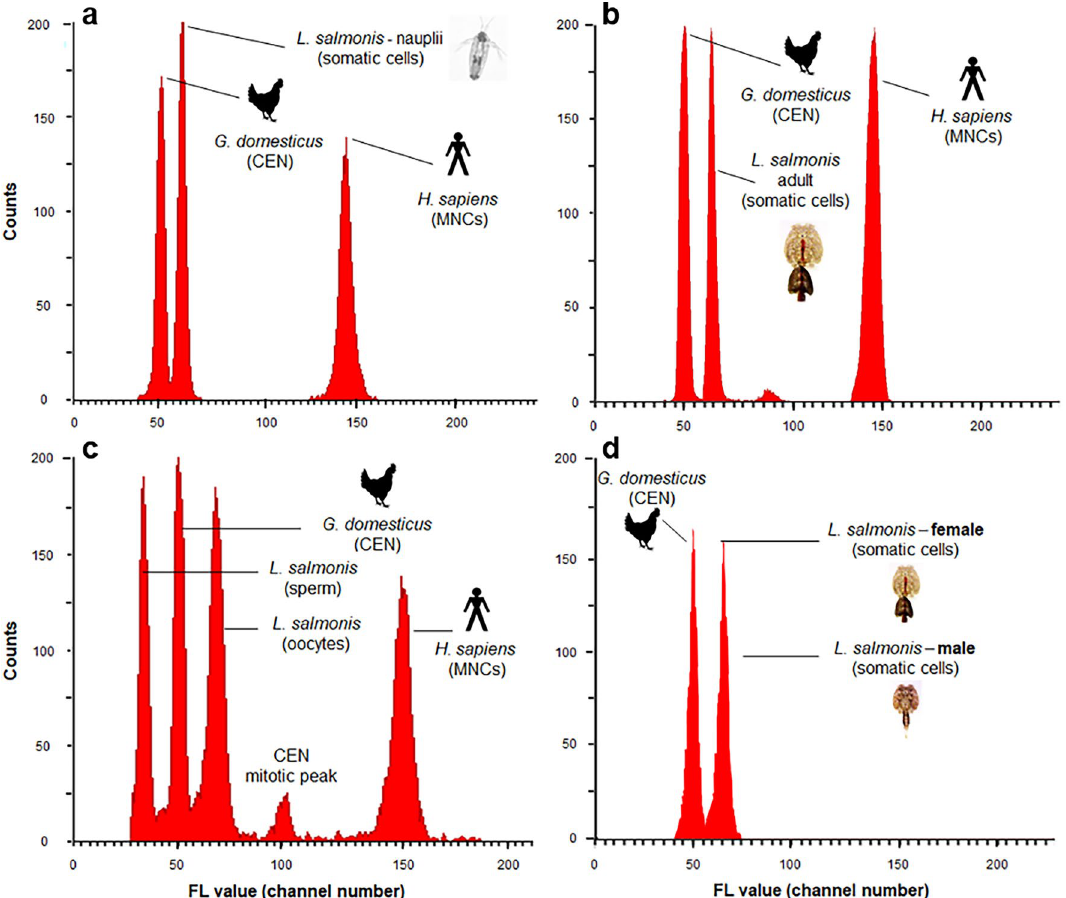
Figure 1. Representative fluorescence histograms of PI-stained somatic and gametic cells of L. salmonis salmonis . ( a ) Run 1, somatic cells obtained from whole body squash of nauplii; ( b ) run 3, somatic cells obtained from cephalic regions of adult females; ( c ) run 4; oocyte and sperm samples; ( d ) run 5, somatic cells obtained from cephalic regions of adult males and females. Samples analyzed using chicken and human cells as internal reference standards. Fluorescence (FL) peaks values on the X-axis are reported in arbitrary units expressed as Propidium Iodide (PI) fluorescence channel numbers (FL value). Values on the Y-axis (counts) refer to the number of nuclei counted per channel. CEN chicken erythrocytes nuclei, MNCs human mono-nucleated